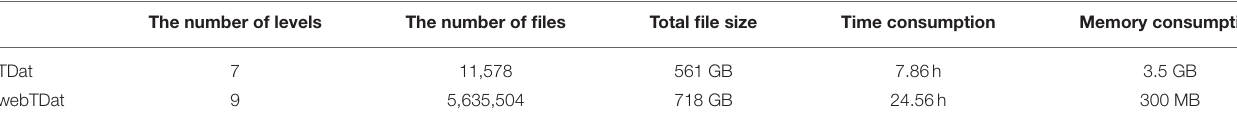
TABLE 1 | Comparison of data reformatting performance between webTDat and TDat. The number of levels The number of files Total file size Time consumption Memory consumption TDat 7 11,578 561 GB 7.86h 3.5 GB webTDat 9 5,635,504 718 GB 24.56h 300